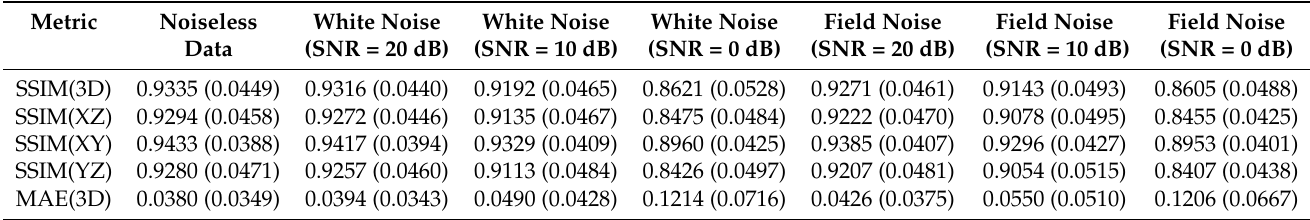
Table 2. 3D velocity model building quality comparison. All values are reported as: Mean(Std), MAE results are in [Km/s]. Results with salt geometry augmented models are included in this